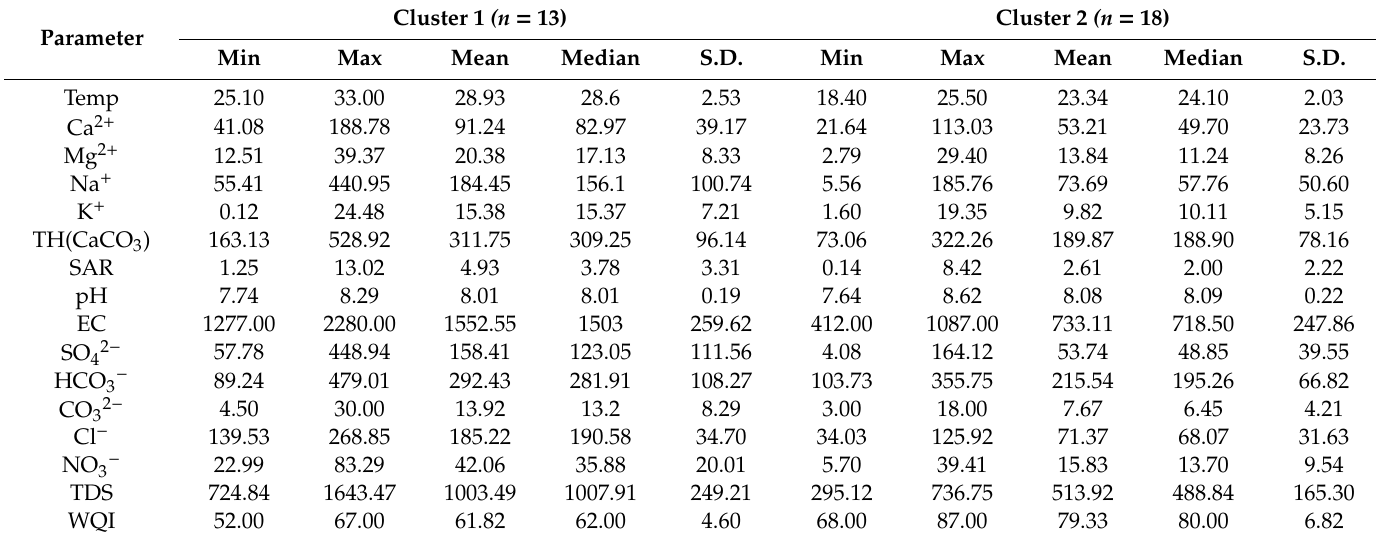
Table 5. Descriptive statistics for the two groups found from K-means clustering